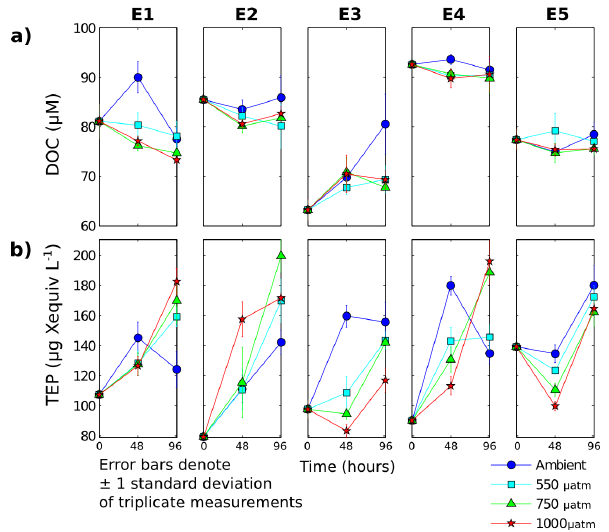
Figure 5. Relationship between the initial p CO 2 of each experi- ment (actual values) and the production per day of (a) dissolved organic carbon ( 1 DOC; µMd − 1 ) and (b) transparent exopolymer particles ( 1 TEP; µgXequivL − 1 d − 1 ) for the time steps 0 to 48h (left) and 0 to 96h